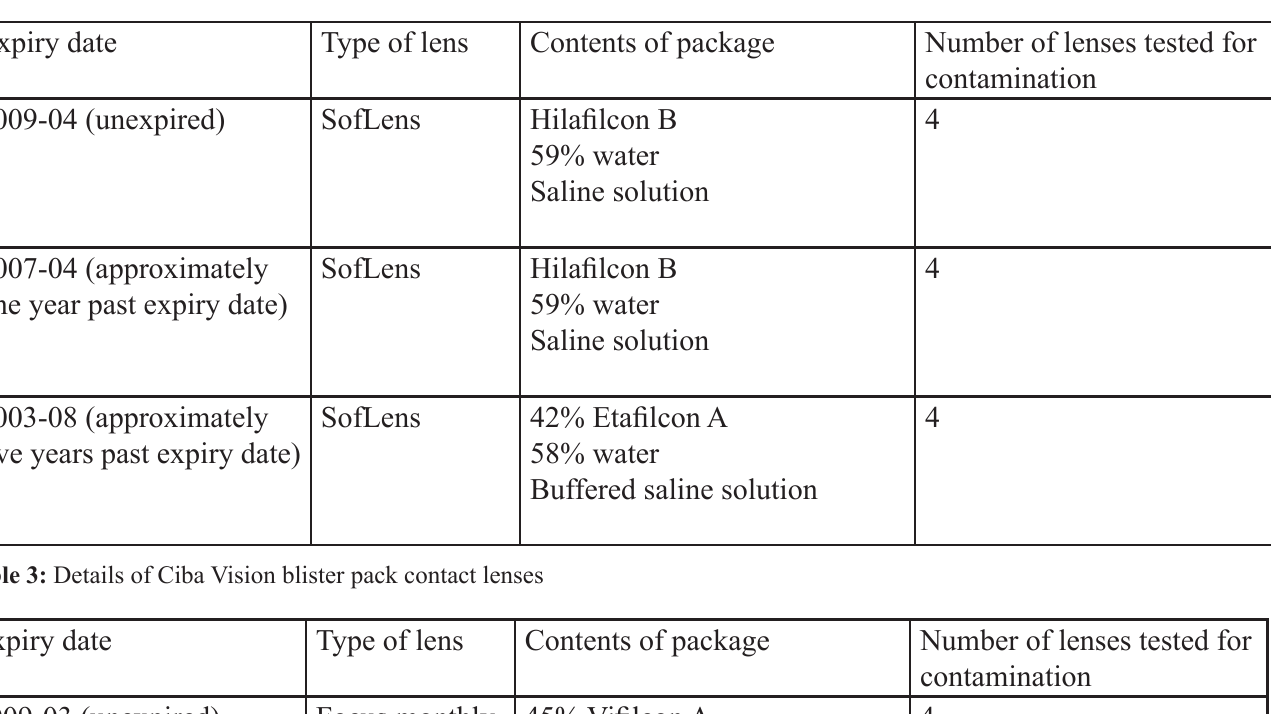
Table 2: Details of Bausch and Lomb blister pack contact lenses